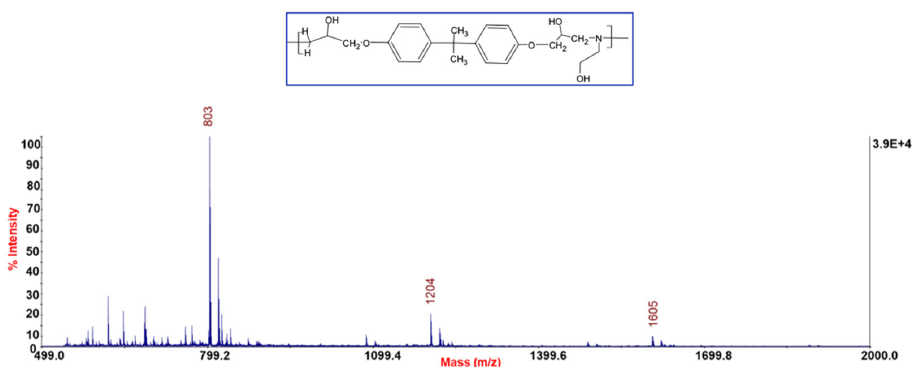
Figure 5. MALDI-MS spectra of rTP recycled polymer. Within the blue box is shown the correspond- Figure 5. MALDI ‐ MS spectra of rTP recycled polymer. Within the blue box is shown the corre ‐ ing repetitive unit’s chemical structure. sponding repetitive unit’s chemical structure.